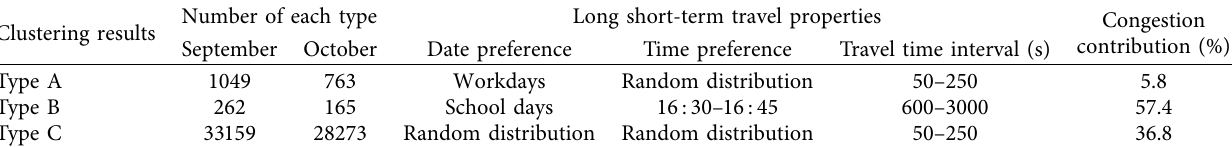
Table 2: Clustering results on the case road from September 1 to October 30.